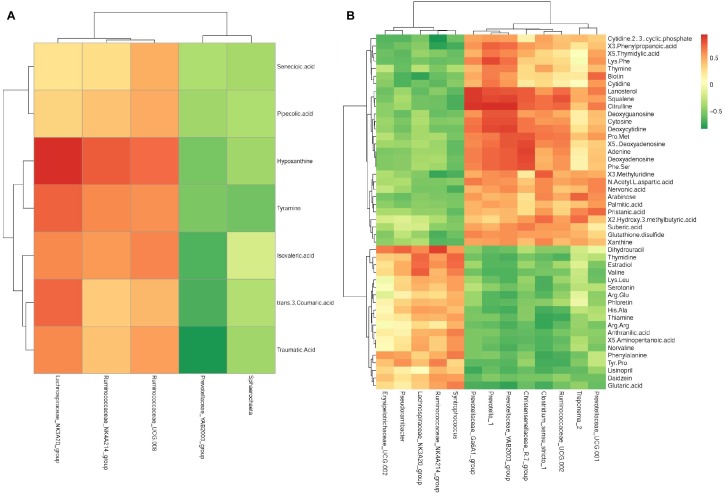
Correlation matrix between the ruminal differential metabolites (used in Table 2) affected by the saponins treatment and the differential microbiota at the genera level (used in Table 3). Positive correlations are shown in red and negative correlations in green. Color intensity is proportional to the correlation values [r] within a correlation group (A) alfalfa hay group, (B) soybean hull group.